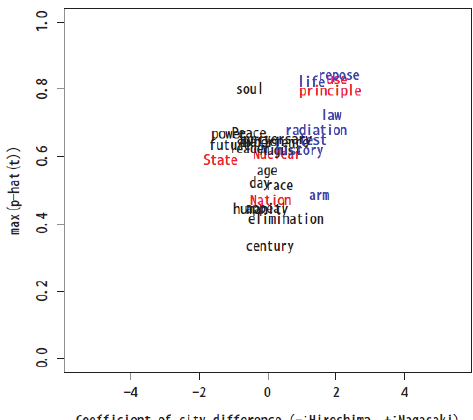
Fig. 22. Scatter plot of keyword's appearance by cluster in 1997